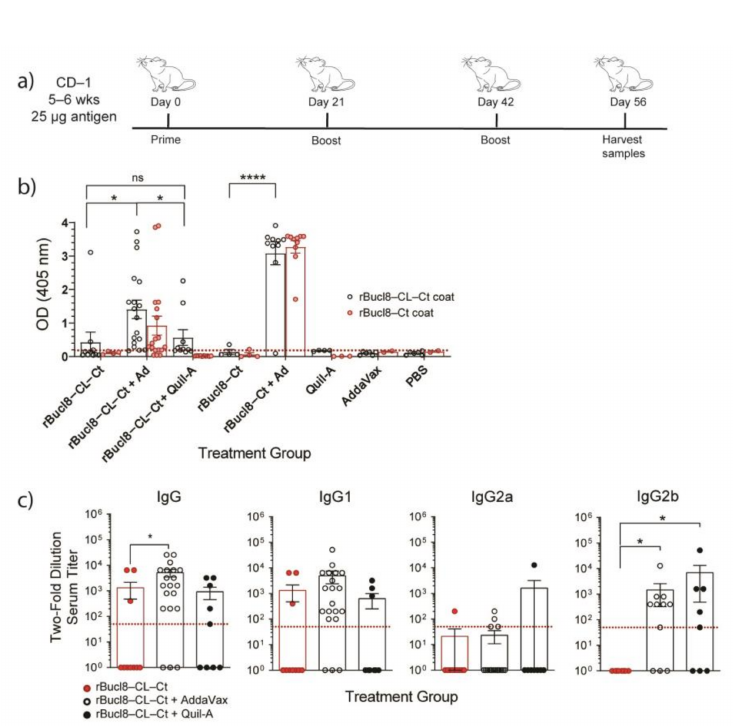
Figure 3. Immunogenicity of recombinant Bucl8-derived antigens. ( a ) Vaccine schedule. ( b ) Antigen- specific IgG response. Sera (1:50 dil) from CD-1 mice immunized with recombinant proteins rBucl8- CL-Ct or rBucl8-Ct, with and without adjuvant (AddaVax or Quil-A) were screened for total antigen- specific IgG level by ELISA. Wells were coated with either rBucl8-CL-Ct (black circle) or rBucl8- Ct (red circle). One-way ANOVA with Tukey’s post-hoc. Red line represents background OD. ( c ) Antigen-specific IgG subclasses. Sera obtained from rBucl8-CL-Ct treatment groups were analyzed, as indicated in the legend. Antibody titers were determined following two-fold dilution, starting at 1:50, until the OD 405 was less than two-times the OD 405 of BSA control. Red dotted line represents lowest positive titer (1:50). SEM error bars. Kruskal Wallis with Dunn’s post-hoc test * p <